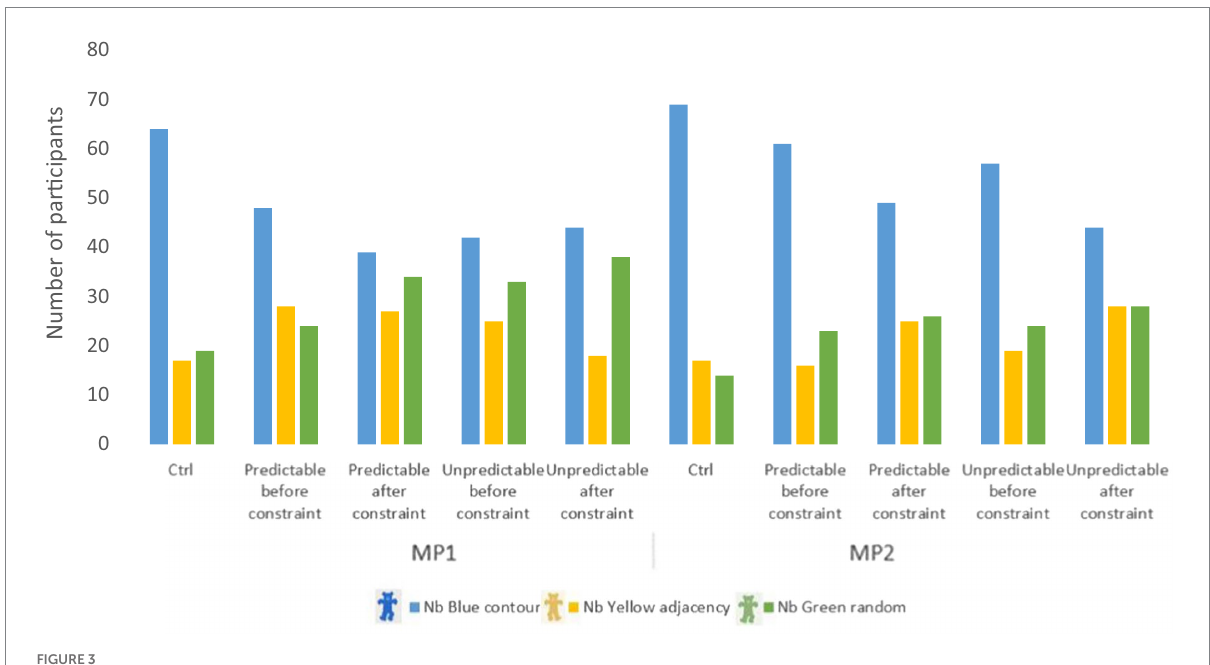
FIGURE 3 Evolution of goal selection collected with GCTBs by measurement point and conditions, before and after